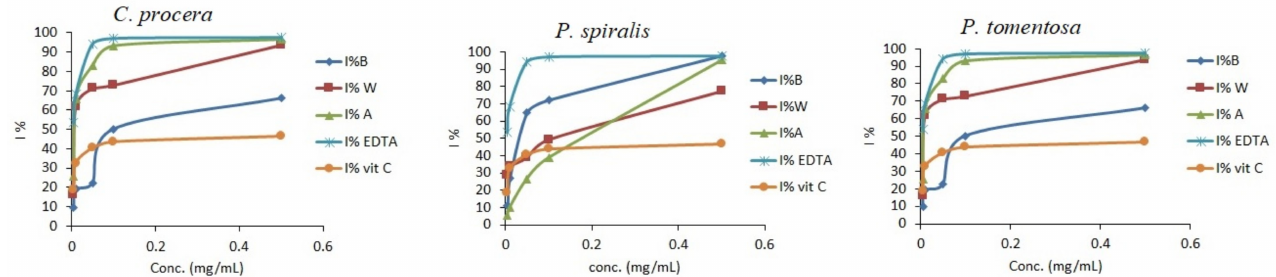
Figure 4. Antioxidant activity of crude extracts from C. procera , P. spiralis , and P. tomentosa and standards using the HDR method. B = butanol extract, A = aq. MeOH extract, W = water extract.